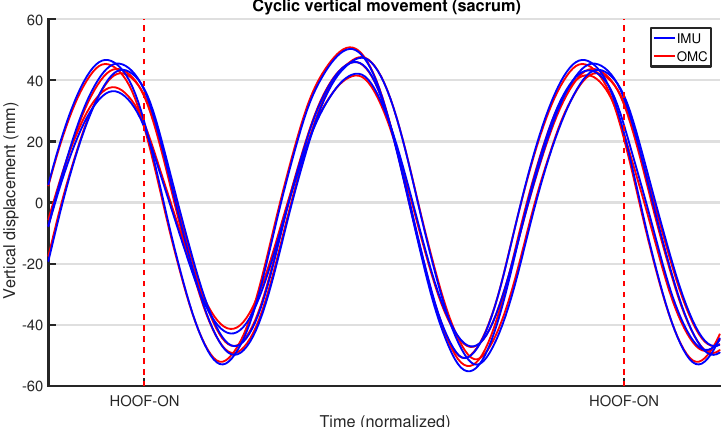
Figure 15. Example of the vertical displacement at the sacrum for IMU and OMC systems. The vertical dashed lines indicate the left hindlimb hoof-on moments used for stride